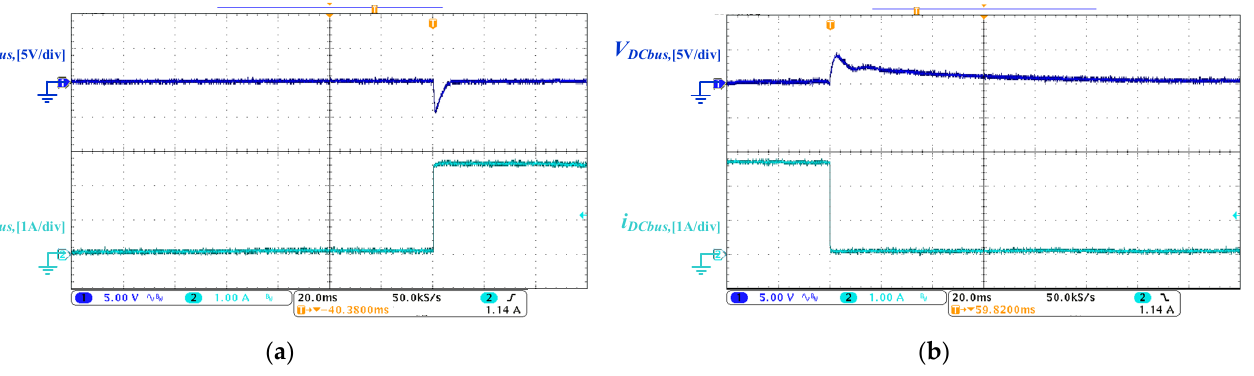
( a ) load change from 10 W to 1 kW; ( b ) load change from 1 kW to 10 W.